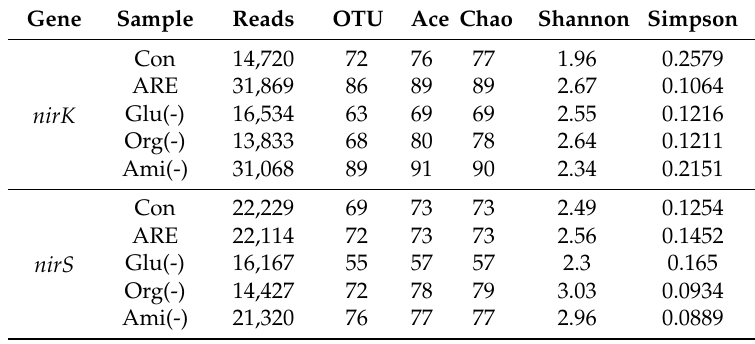
Table 3. Bacterial taxonomic richness and diversity coverage